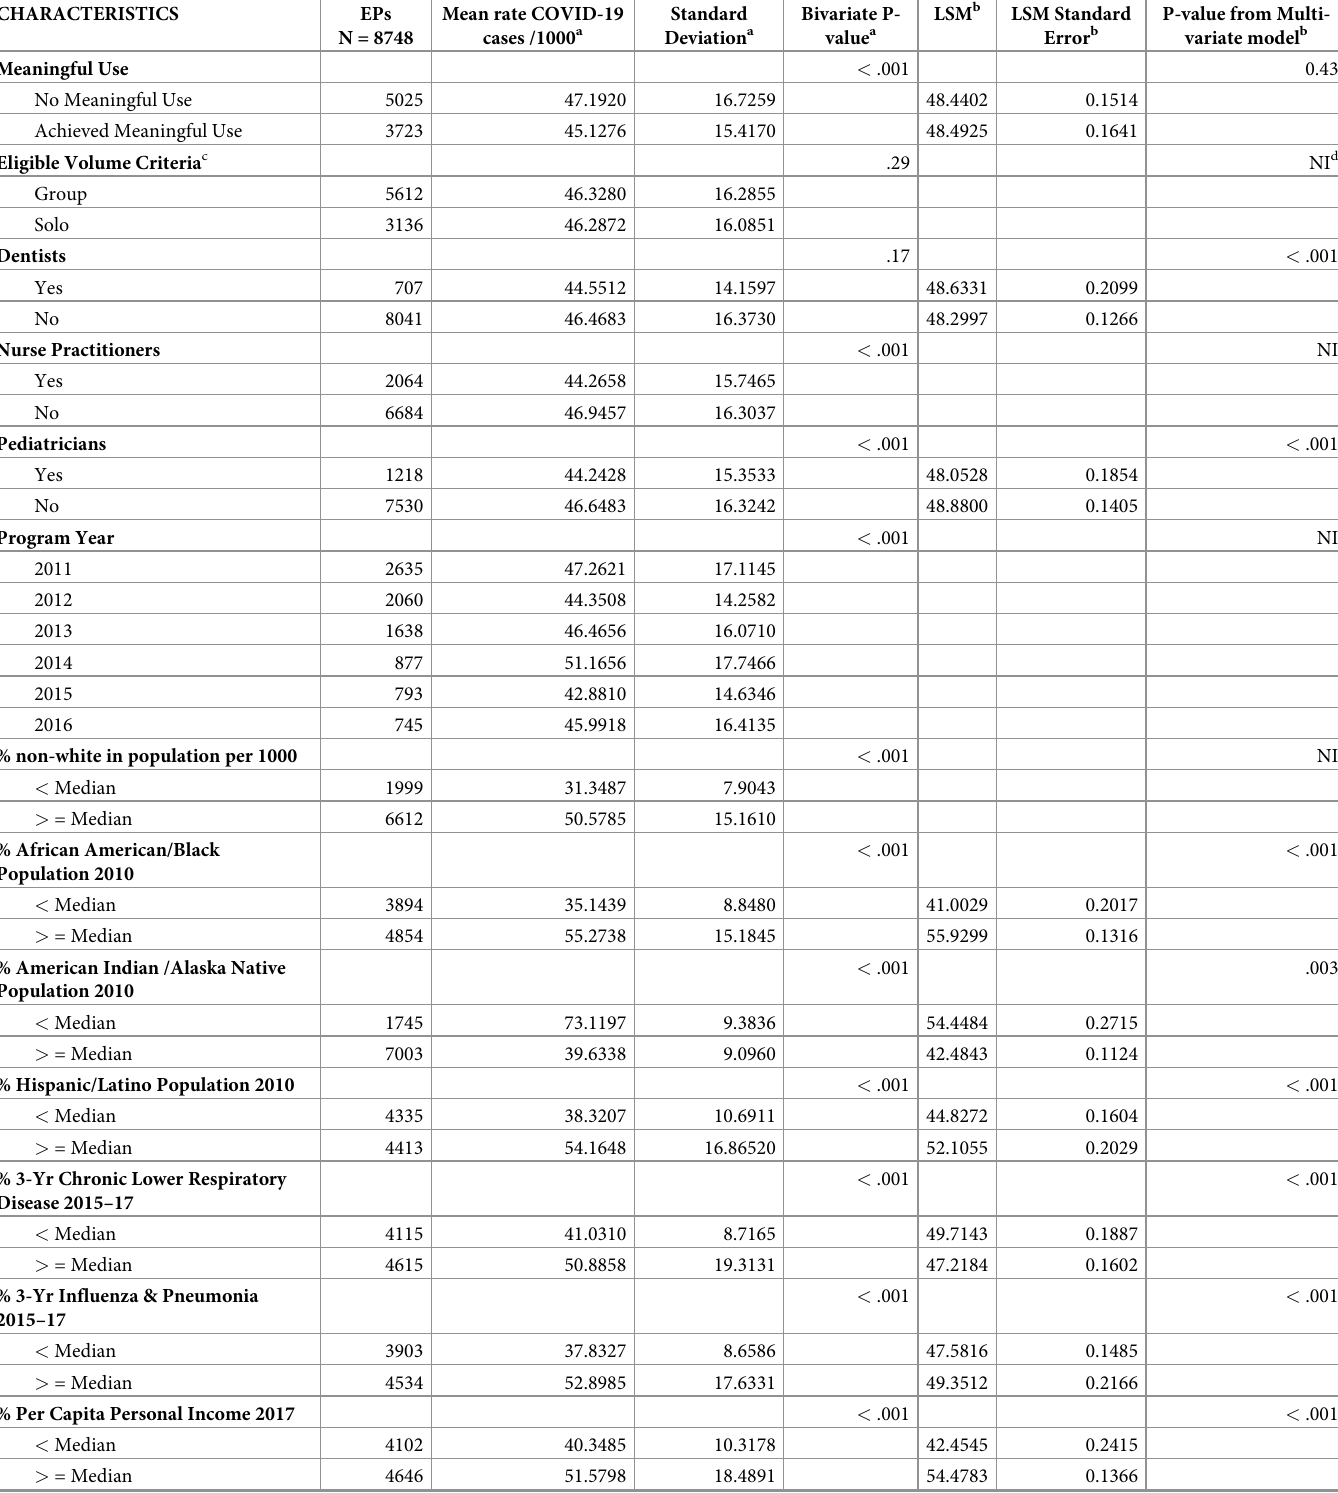
Table 2. Characteristics associated with COVID-19 case rates among Florida county